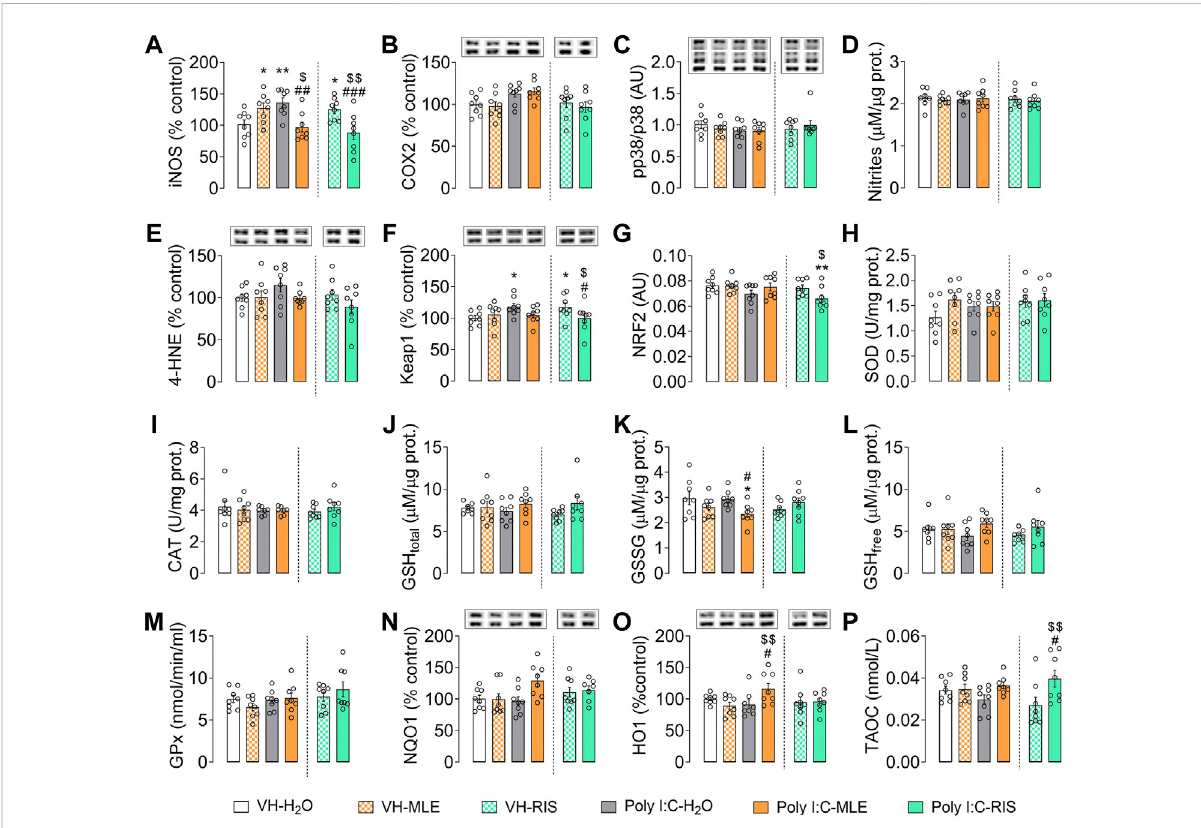
FIGURE 4 The effect of adolescent MLE or risperidone (RIS) treatment on the expression of oxidative/in fl ammatory mediators in the PFC. (A – C) The expression of the in fl ammatory mediators iNOS, COX2 and p38 relative to the controls, represented as the percentage (%) change, except for p38 which is represented as the ratio of phosphorylated relative to total p38 protein. (D,E) The concentrations of the indicators of oxidative/ nitrosative damage (nitrites and 4-HNE) are expressed as µM/µg of protein, and as the % of the control expression. (F – P) Evaluation of the biomarkers of compensatory antioxidant mechanisms (Keap1, NRF2, SOD, CAT, GSH/GSSG, GPx, NQO1, HO1, TAOC). Keap1, NQO1 and HO1 expression is represented as the % of the controls; NRF2 activity is expressed in arbitrary units (AU); SOD and CAT enzyme activities are expressed as U/mg of protein; the levels of total (GSH total ), oxidized (GSSG) and reduced (GSH free ) glutathione are expressed as μ M/µg of protein; Glutathione Peroxidase (GPx) is expressed as nmol/min/ml; and the Total Antioxidant Capacity (TAOC) is expressed in nmol/L. The data are represented as the mean ± SEM of 7-8 PFC samples per group. Representative bands of iNOS, COX2, 4-HNE, Keap1, NQO1 and HO1 (upper bands), andofthe β -actinloadingcontrol(lowerbands),areshownabovetheircorrespondingbarsinthegraph.Forp38proteinexpression,phosphorylated and total p38 representative bands are shown relative to β -actin (lower bands). * p < 0.05, ** p < 0.01 vs. VH-H 2 O; $ p < 0.05, $$ followed by the LSD post-hoc